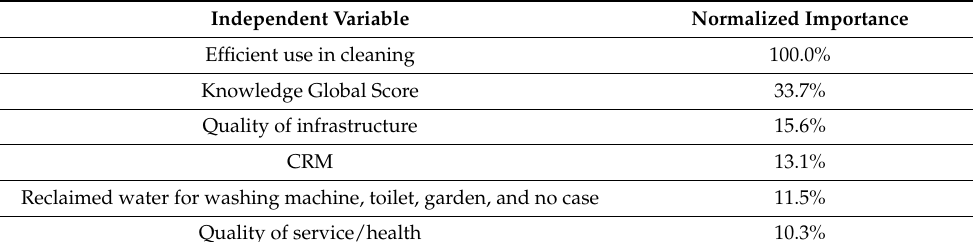
Table 2. Importance of the independent variable of knowledge, values/needs, and attitudes together to predict the range of household consumption. (Source: